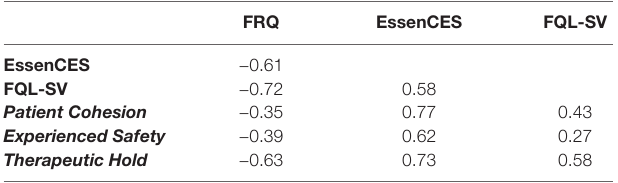
TaBle 4 | Spearman correlations between FRQ, FQL-SV, and EssenCES (and domains). FRQ